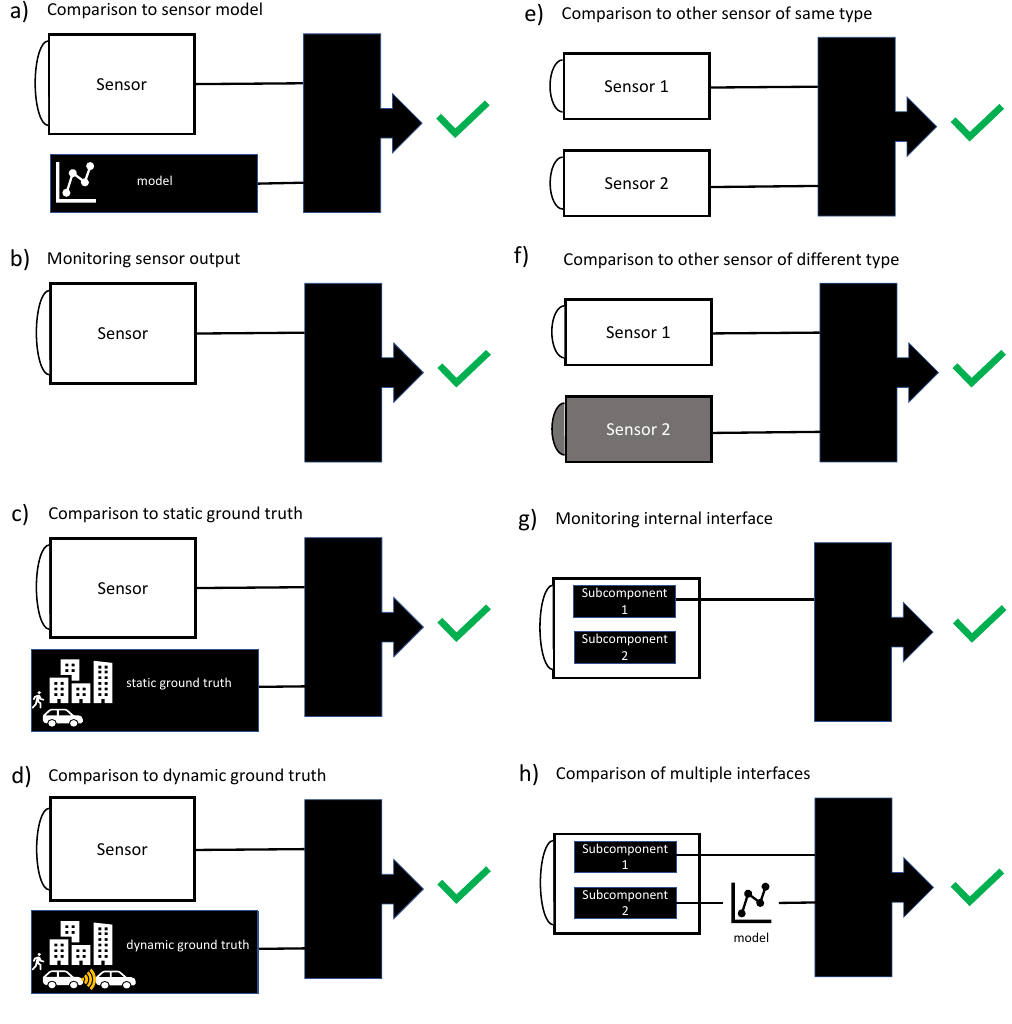
Figure 3. Schematic illustration of FDII